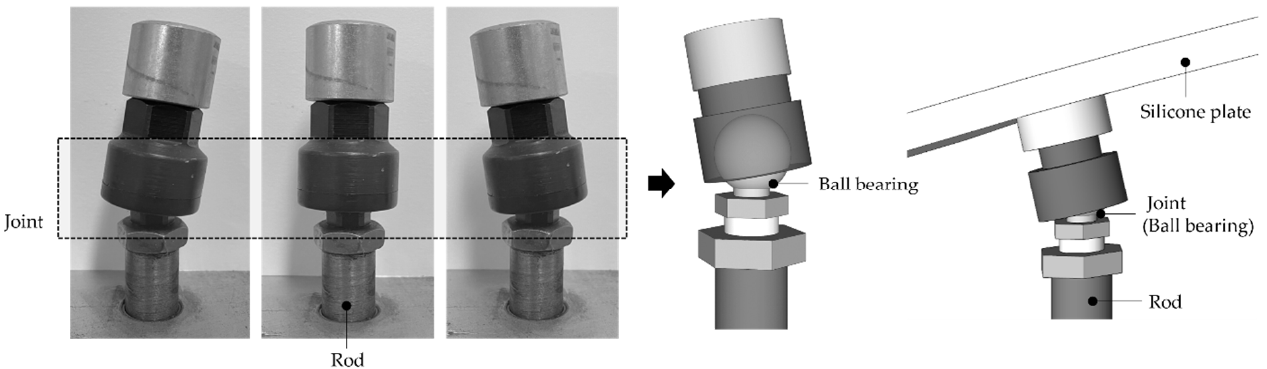
Figure 1. Fixed type.